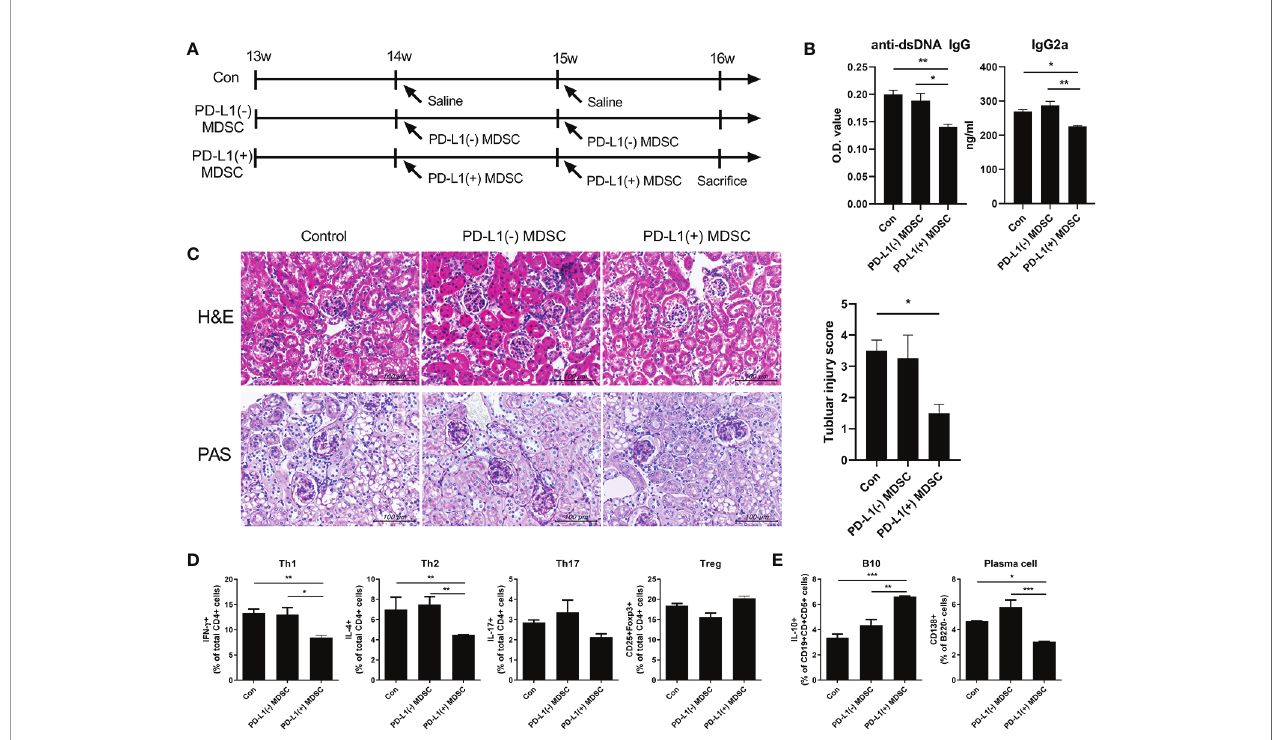
FIGURE 3 | In vivo treatment with PD-L1 positive MDSCs shows better therapeutic effects in lupus prone Roquin san/san mice. (A) 13-week-old Roquin san/san mice (n=5 in each group) were treated intravenously with 1 × 10 6 PD-L1 positive and/or negative MDSCs from C57BL/6 mice or vehicle (saline) once a week for 2 weeks. One week after the last treatment, Roquin san/san mice was sacri fi ced. (B) Serum levels of IgG2a and anti-dsDNA IgG in Roquin san/san mice treated with PD-L1 positive or negative MDSCs or saline, as determined by ELISA. (C) Representative images of hematoxylin and eosin (H&E) and PAS staining of the kidney sections are shown in the left panel. Tubular injury score is shown in the right panel. (D) Flow cytometric analysis shows the populations of CD4+IFN- g T cells (Th1 cells), CD4+IL-4+ T cells (Th2 cells), CD4+IL-17+ T cells (Th17 cells), CD4+CD25+FOXP3+ cells (Treg cells) in spleen tissues from Roquin san/san mice. Data are expressed as the mean ± SEM. Data are representative of 2 independent experiments. Relative bar charts are shown. (E) Flow cytometric analysis shows the populations of B220-CD138+ cells (plasma cells) and CD19+CD1d+CD5+IL-10+ cells (IL-10 producing B10 cells) in spleen tissues from Roquin san/san mice. Relative bar charts are shown. (* P < 0.05, ** P < 0.01, *** P <